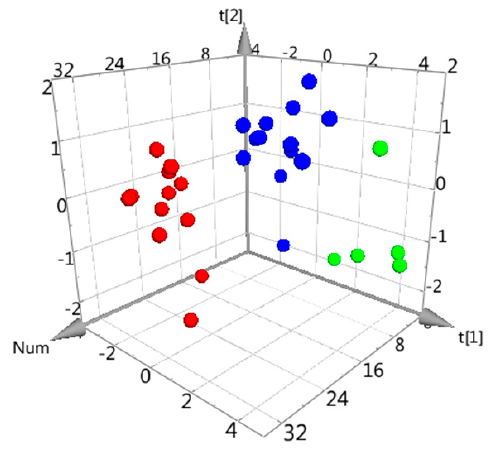
Figure 2. The Principal Component Analysis Three-Dimensional (PCA 3D) scores plot using AH bitterness data. ● : Leaf, ● Stem/Leaf, ● : Stem. bitterness